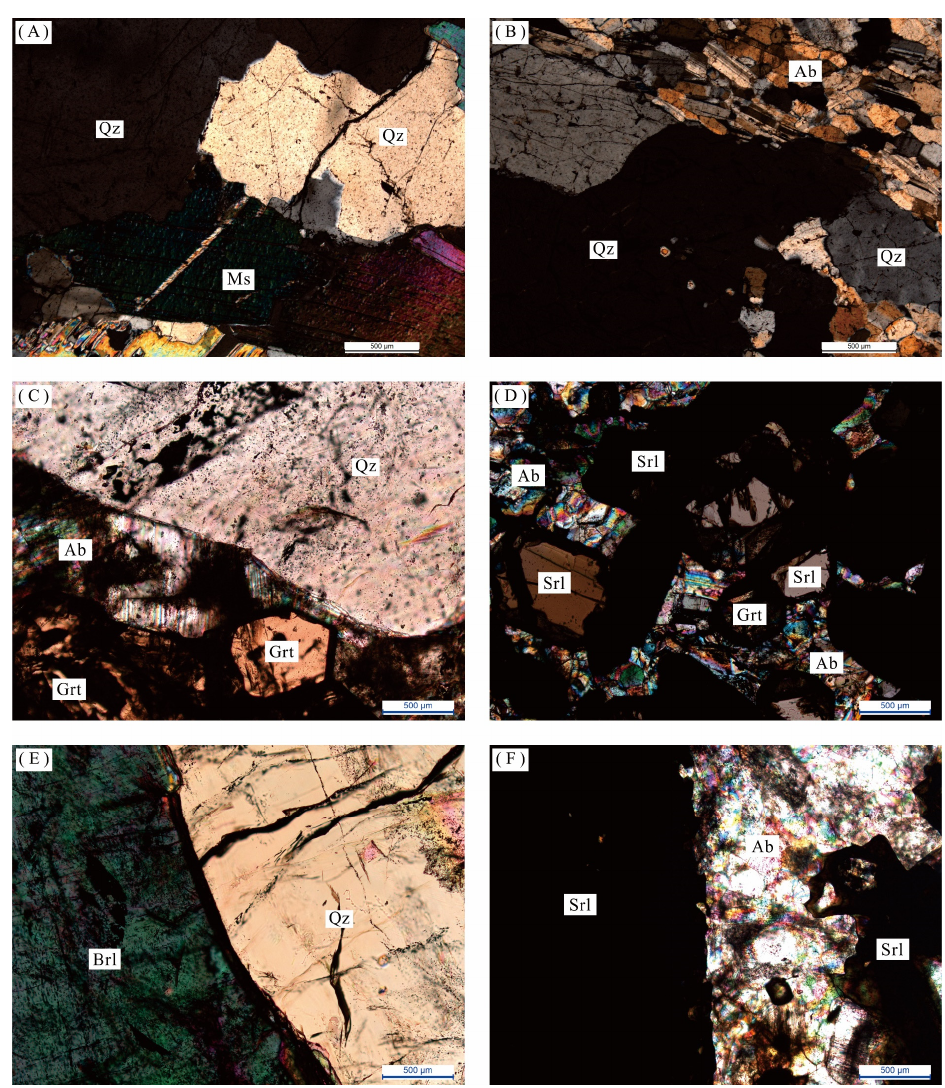
Figure 5. Microscopic characteristics of samples from different mineral textural zones. ( A ) Quartz- muscovite combination (crossed polarized light); ( B ) Quartz-albitite combination (crossed polarized light); ( C ) Quartz-albite-garnet combination (crossed polarized light); ( D ) Albite-schorl-garnet combination (crossed polarized light); ( E ) Quartz-beryl combination (crossed polarized light); ( F ) Albite- schorl combination (crossed polarized light). Quartz = Qz ; Albite = Ab; Microcline = Mc; Schorl = Srl; Beryl = Brl; Muscovite = Ms; Garnet = Grt.